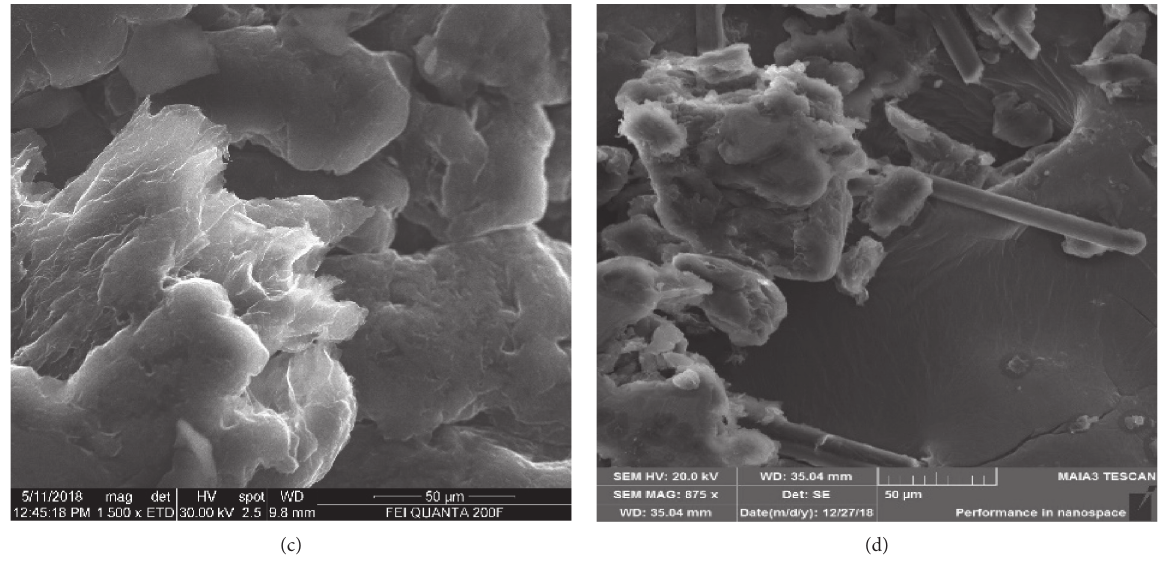
Figure 4: SEM micrographs of (a) CF, (b) HDPE, (c) PW/EG, and (d)